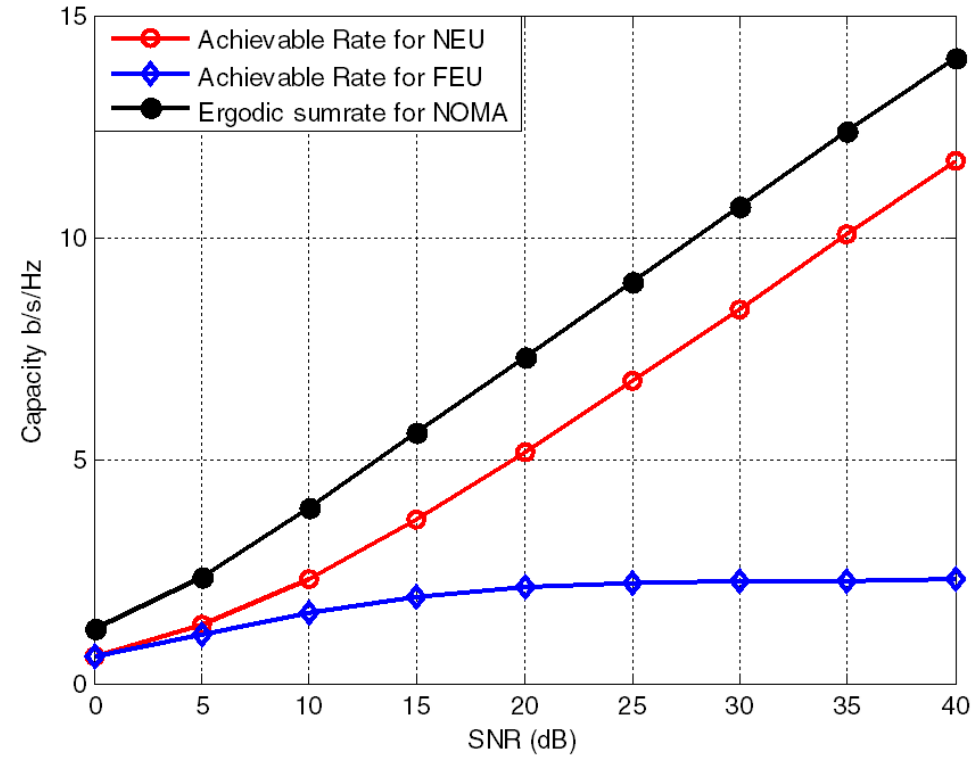
Figure 12. Capacity performance of the NOMA